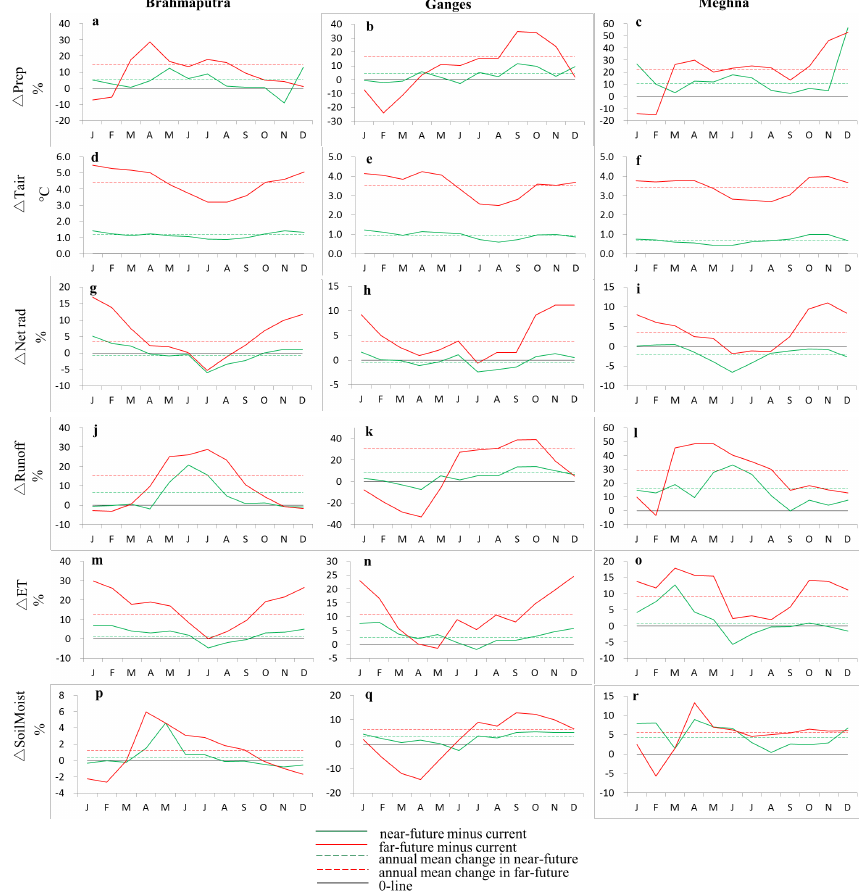
Figure 9. (a) – (r) Percentage changes in the monthly means of the climatic and hydrologic quantities from the present-day period to the near-future and far-future periods. The dashed lines represent the annual mean